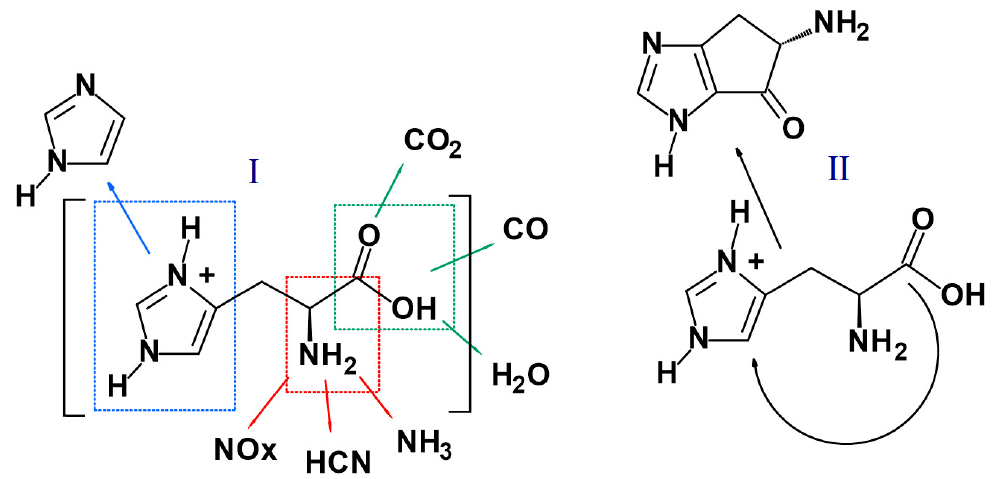
Figure 15. Proposed decomposition mechanism for histidine.